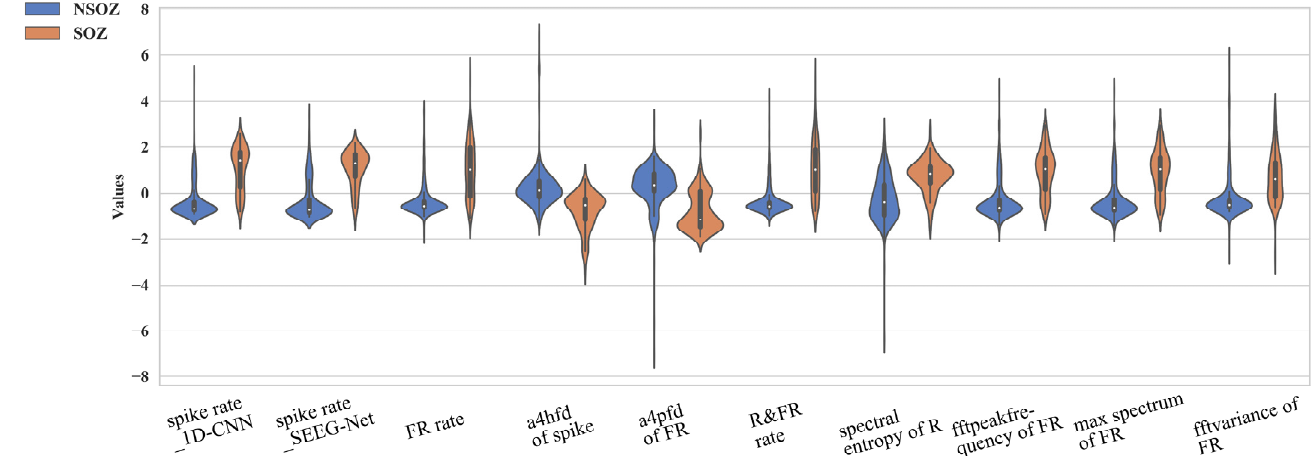
Figure 6. The ranking of the top ten most important features for patients.